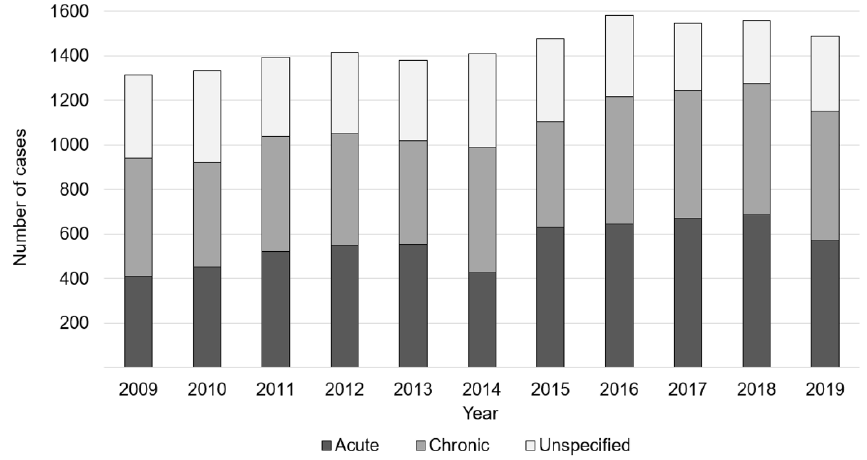
Figure 4. Development of osteomyelitis prevalence, classified as acute, chronic, and unspecified.